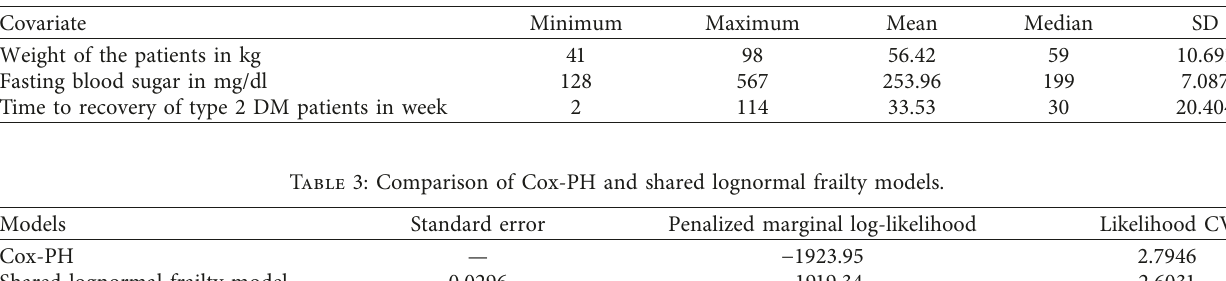
Table 2: Descriptive statistics for continuous covariate included in the